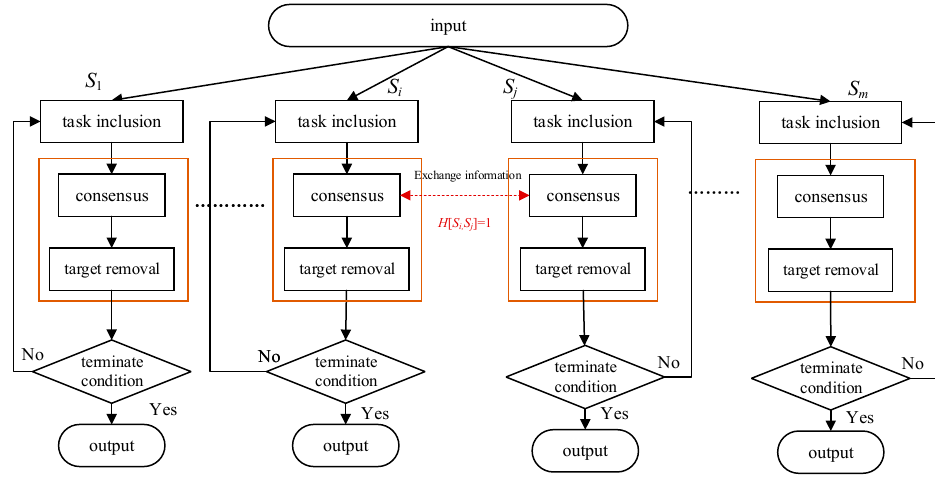
Figure 5. The framework of the PI algorithm.